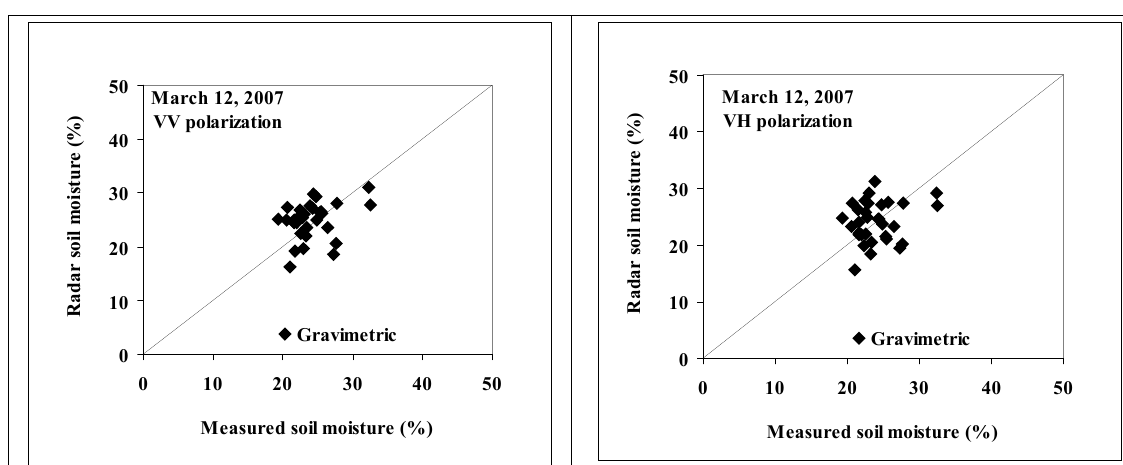
Figure 4. Comparison between soil moisture estimated by ASAR image acquired the March 12, 2007 and soil moisture measured by gravimetry (at the field scale). Bias “Radar-Gravimetry”=0.34%; standard deviation=3.78%; MAE=3.06%; RMSE=3.74%;